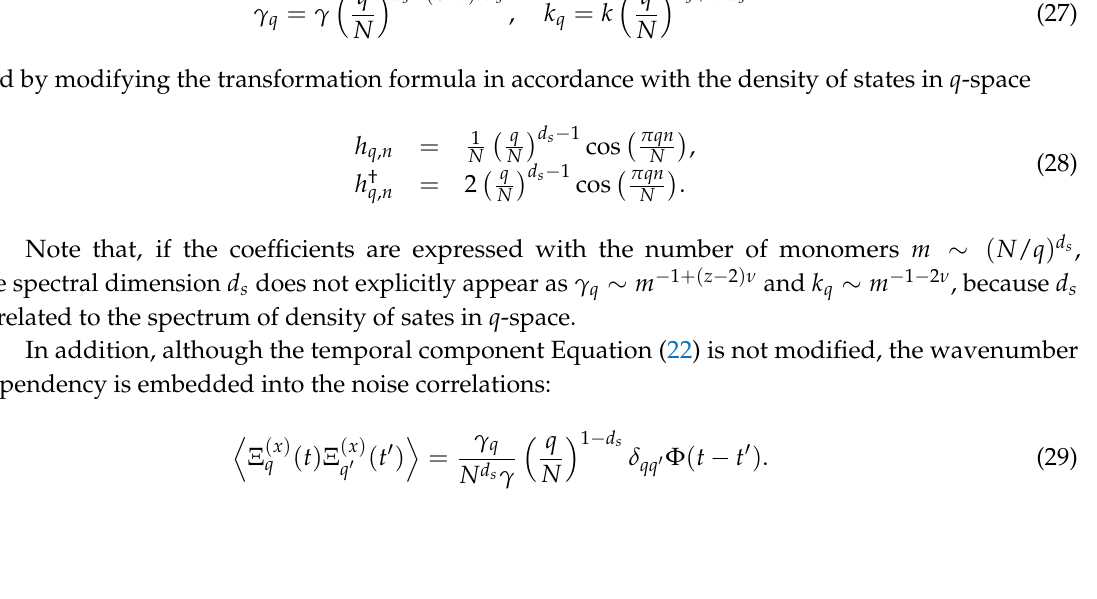
Figure 3. Sketches of MSDs scales. The active noise with ( a ) strong γ k B T / τ A < A or ( b ) weak γ k B T / τ A > A magnitude,